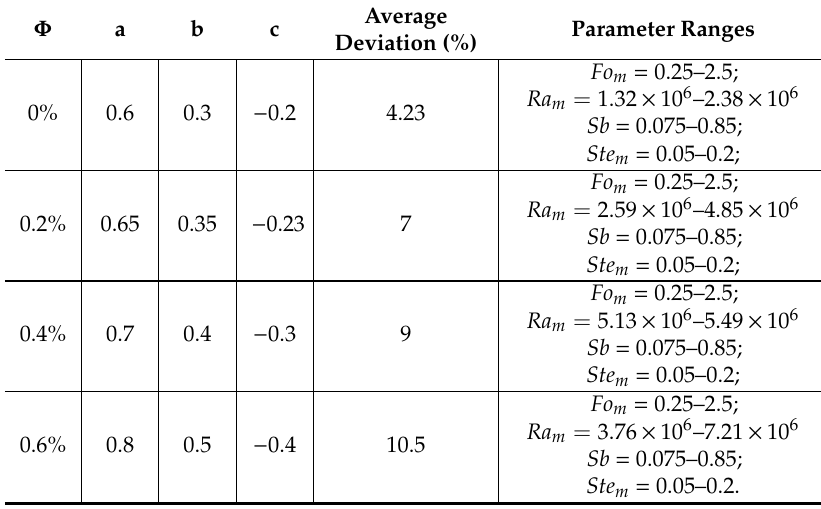
Table 5. Coe ffi cient, exponents and ranges of parameters for Equation